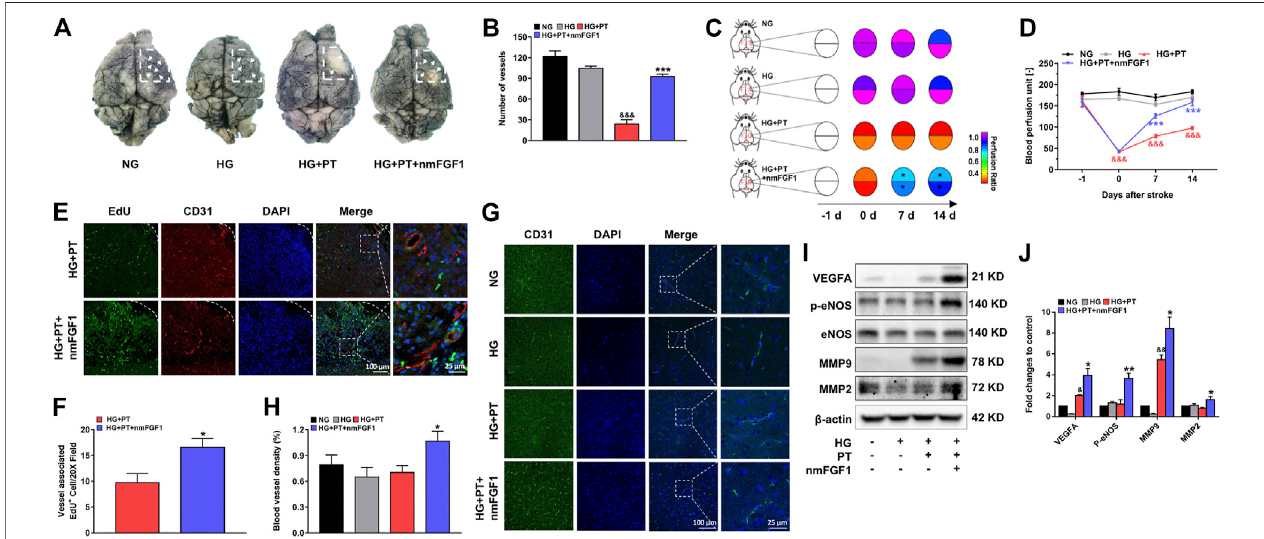
FIGURE 3 | NmFGF1 promoted angiogenesis in a mouse model of diabetic stroke. (A, B) The cerebrovascular density within the ischemic zone on day 7 after ischemic stroke was examined by ink-gelatin perfusion and the quanti fi cation of cerebral vascular density (n (cid:2) 3). (C, D) Blood perfusion in the ischemic area was evaluatedbyalaserdoppler fl owmeteranddescribedbyheatmaps.Bloodperfusionwasquanti fi ed(n (cid:2) 7). (E) Representativeimmuno fl uorescenceimagesofDAPIand EdU stainingalongwith stainingofthe vascular endothelium markerCD31 onday 7 after ischemic stroke. (F) Quantitative analysis ofEdU + /CD31 + co-labeled cells in theischemic areafollowingstroke (n (cid:2) 3). (G) The expression ofCD317days post-strokeasdeterminedbyimmuno fl uorescence analysis. (H) Quantitative analysisof the intensity of CD31 (n (cid:2) 3) (I) The expression levels of VEGFA, p -eNOS, eNOS, MMP9, and MMP2, as determined by western blot analysis. β -actin was used as a loading control (J) The band density of speci fi c proteins was quanti fi ed by image software (n (cid:2) 3). Data are presented as means ± SEM. & p < 0.05, && p < 0.01, &&& p < 0.001 vs. HG group; * p < 0.05, ** p < 0.01, *** p < 0.001 vs. HG + PT group.